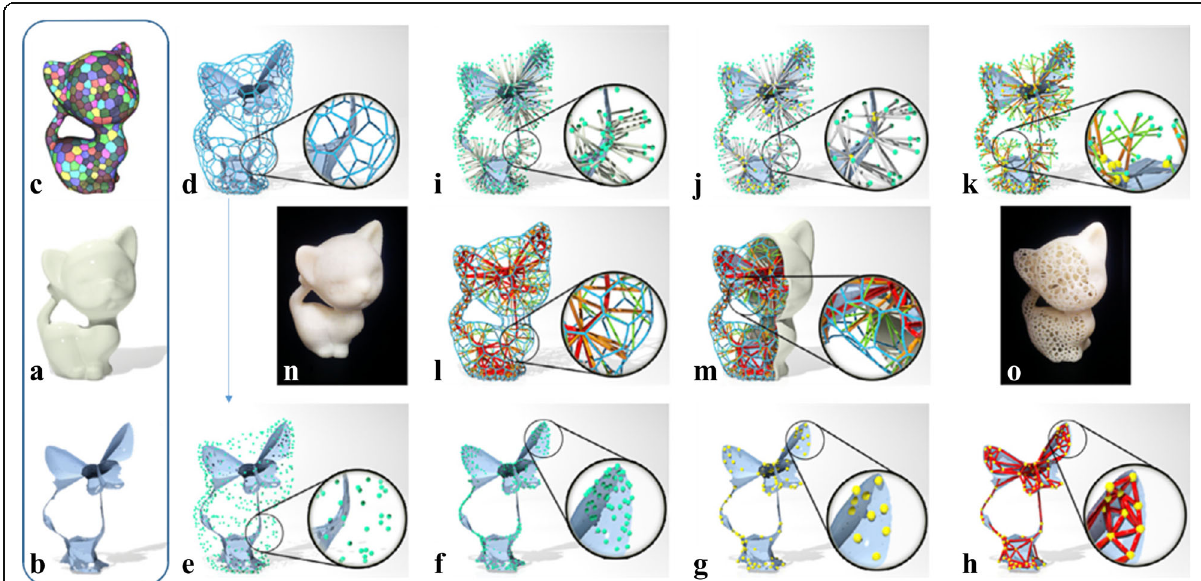
Fig. 3 Lightweight structure design method based on the media axis algorithm. a Origin model. b The media axis. c Restricted centroid voronoi tessellation. d Hexagonal frame. e . Sampling points. f Projection in media axis. g Group nearby points. h Resulting frame. i Connecting results of